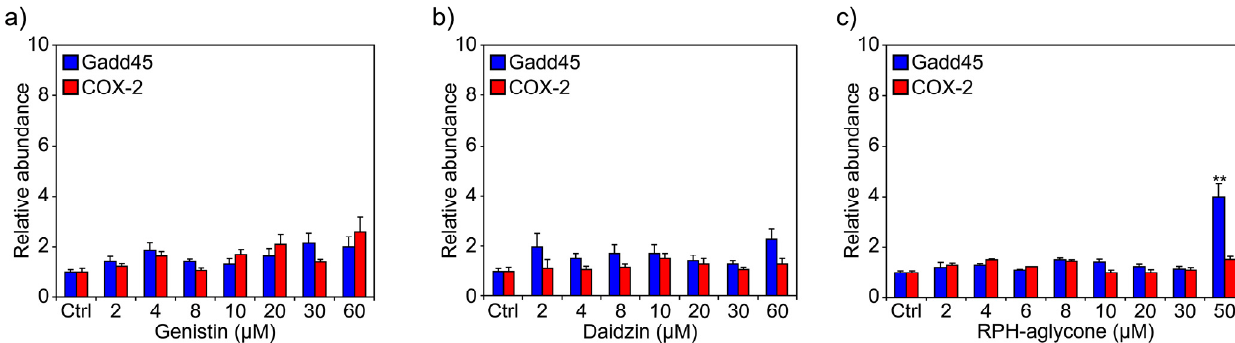
Figure 2. Effects of genistin, daidzin and RPH-aglycone on Gadd45 and COX-2 mRNA levels in unirradiated BJ-5ta cells. Levels of Gadd45 and COX-2 mRNA were determined by real-time PCR using a total RNA preparation from BJ-5ta cells treated with various concentrations of ( a ) genistin (from 2 µM to 60 µM); ( b ) daidzin (from 2 µM to 60 µM); or ( c ) RPH-aglycone (from 2 µM to 50 µM). The cells were harvested 24 h after treatment. The bars indicate the relative abundance of each mRNA; +1 is the abundance of Gadd45 and COX-2 mRNA in untreated cells. All values represent the mean ± SD of triplicate experiments. ** p < 0.001 (Ctrl: untreated control